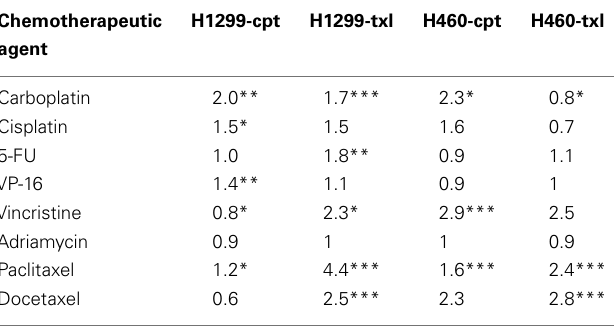
Table 4 | Fold resistance of H1299 and H460 resistant variants compared with their parental cell lines .